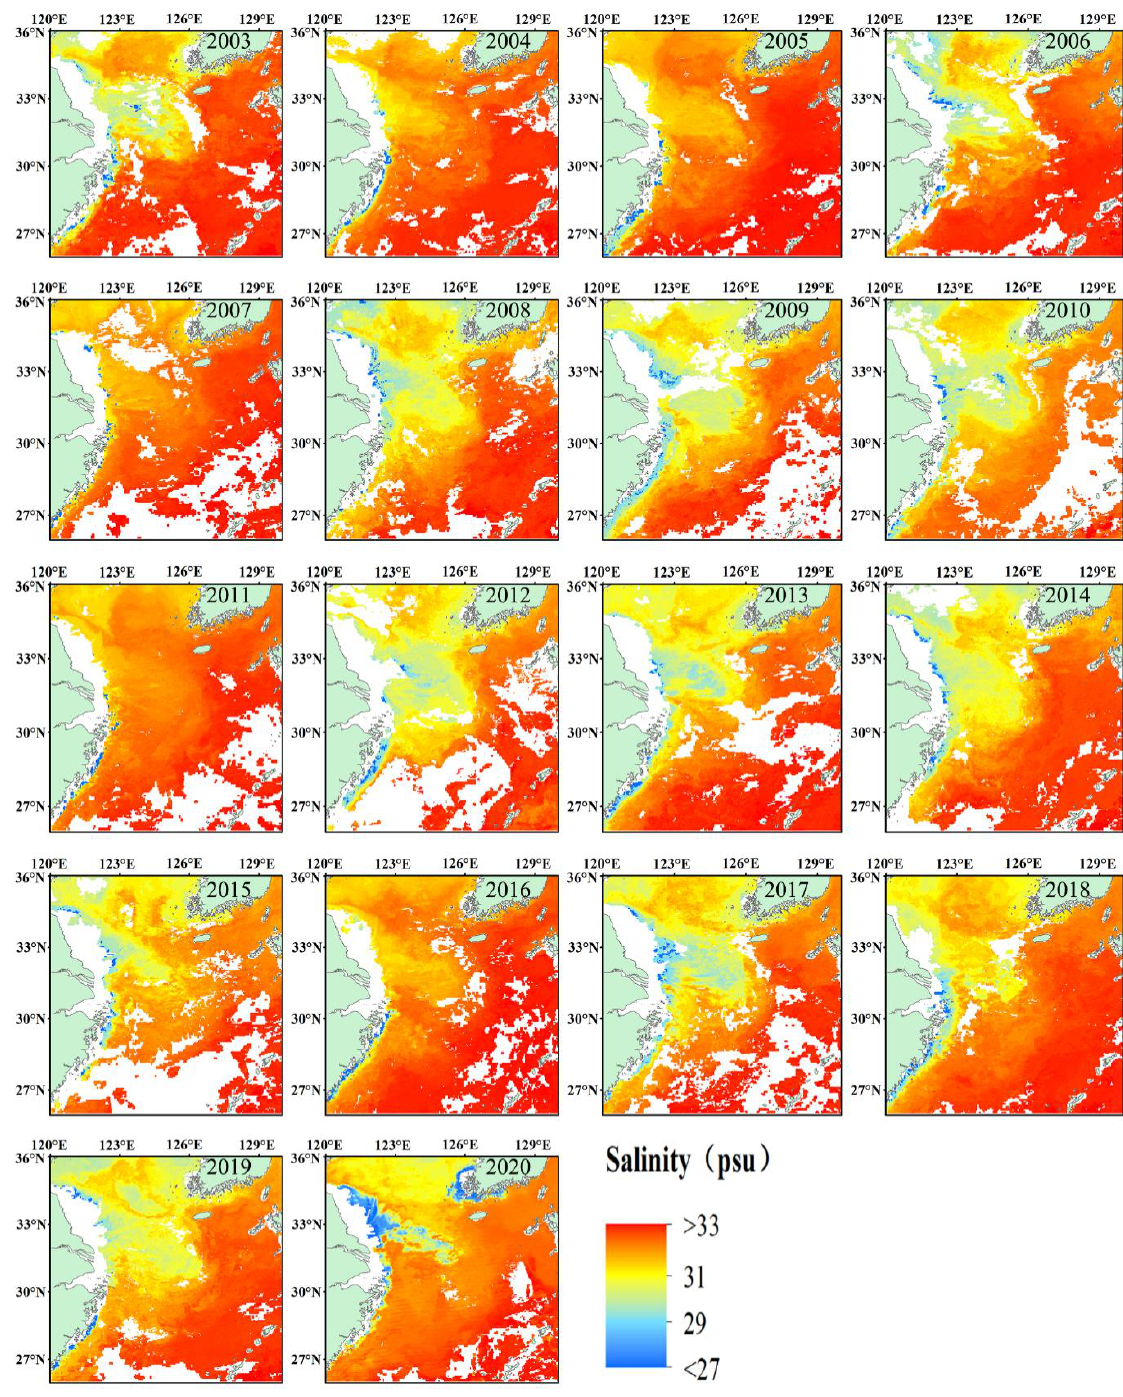
Figure A2. SSS inversion results for March 2003 – 2020.